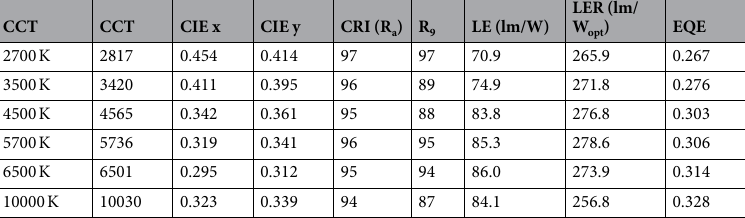
Table 3. Optical properties of PIG-based on-chip COB WLEDs.